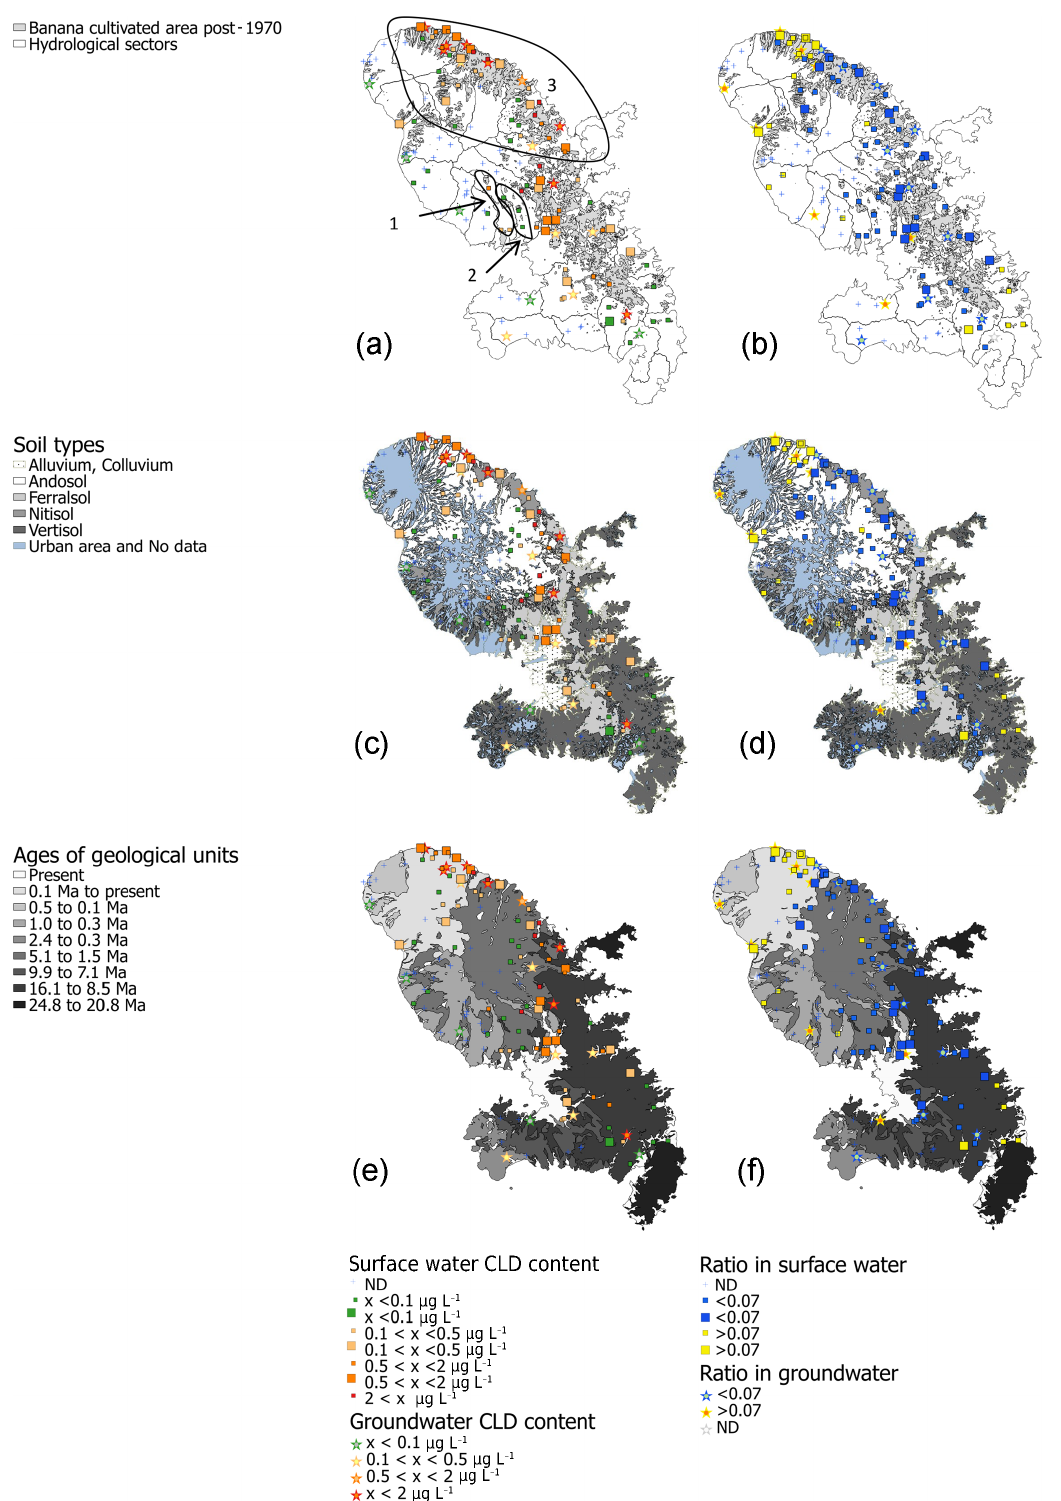
Figure 3. Distribution of water CLD content (a, c, e) and the 5bCLD / CLD ratio (b, d, f) for surface water (square) and groundwater (star), according to banana cultivated areas and hydrological sectors (a, b) , soils (c, d) adapted from Colmet Daage (1965), and geology (e, f) adapted from Germa et al. (2011). Large squares are relative to sample points with more than 10 sampling dates and small squares to those with fewer than 10 sampling